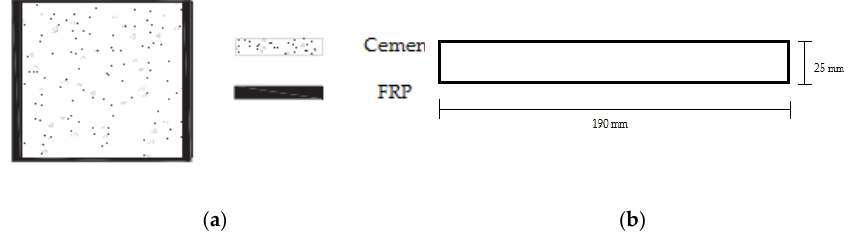
Figure 5. ( a ) Method of smoothing the specimen surfaces; ( b ) priming the surfaces for better adhesion of the fabric. The one-directional carbon fiber fabric that reinforced the cement specimen was placed vertically to the compression force. The fibers of the two-dimensional fabric were vertical in one direction and parallel to the compression force in the other, as illustrated in Figure 1a,b. In addition, the paste epoxy resin was easier to apply during the manufac- turing process.